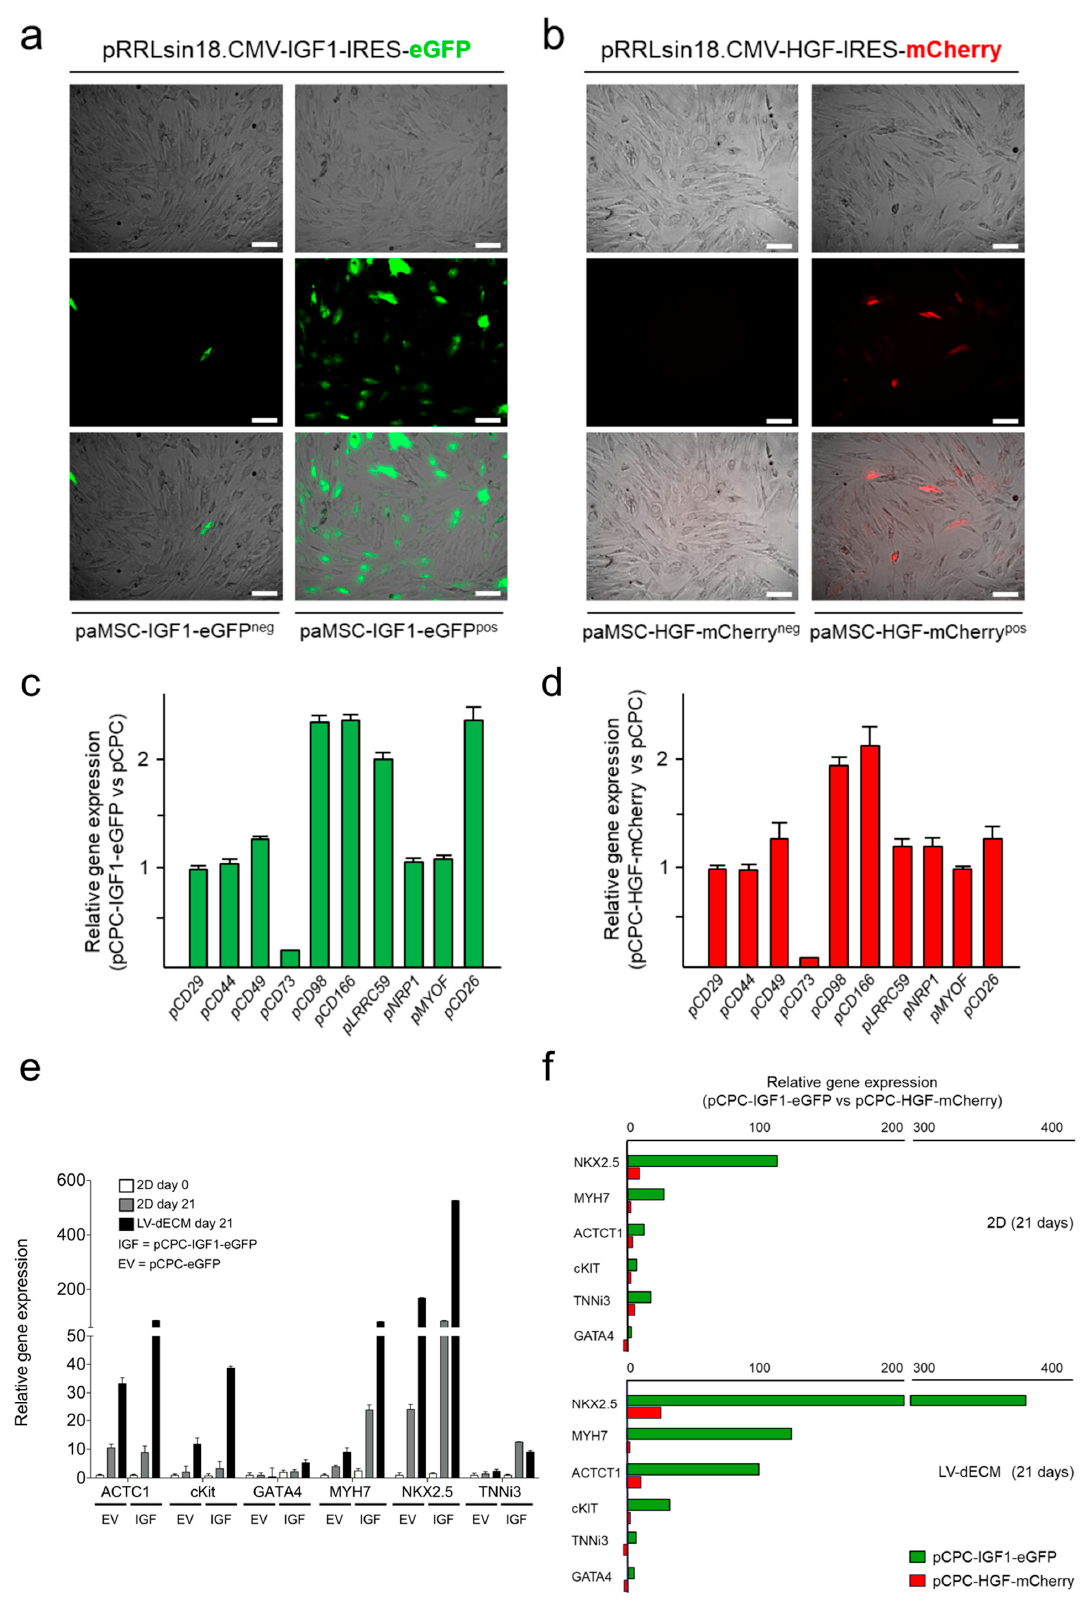
Figure 5. Comparative characterization of IGF1/eGFP and HGF/mCherry in both transduced paMSC and pCPC. ( a ) Fluo- rescent protein expression (eGFP) on transduced paMSC-IGF1-eGFP after cell sorting purification, compared with